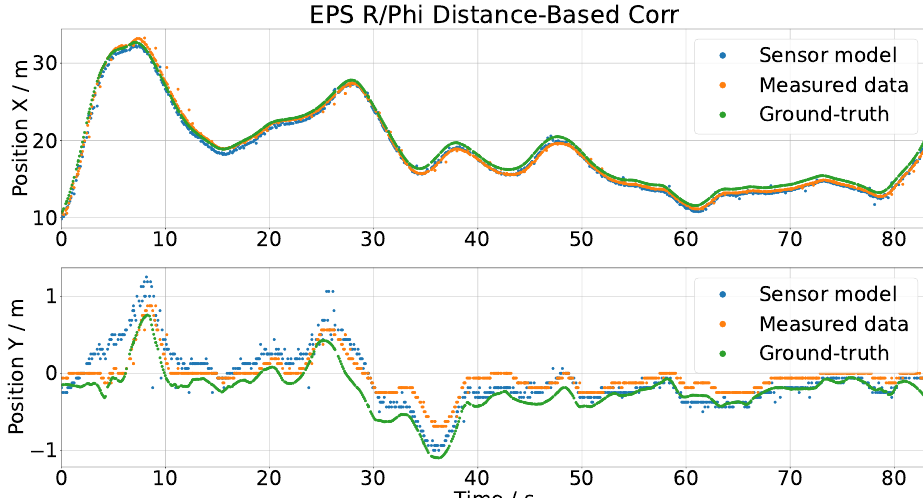
Figure 24. Results of the inertia model extended by the distance-based correction by using the test data as the input.